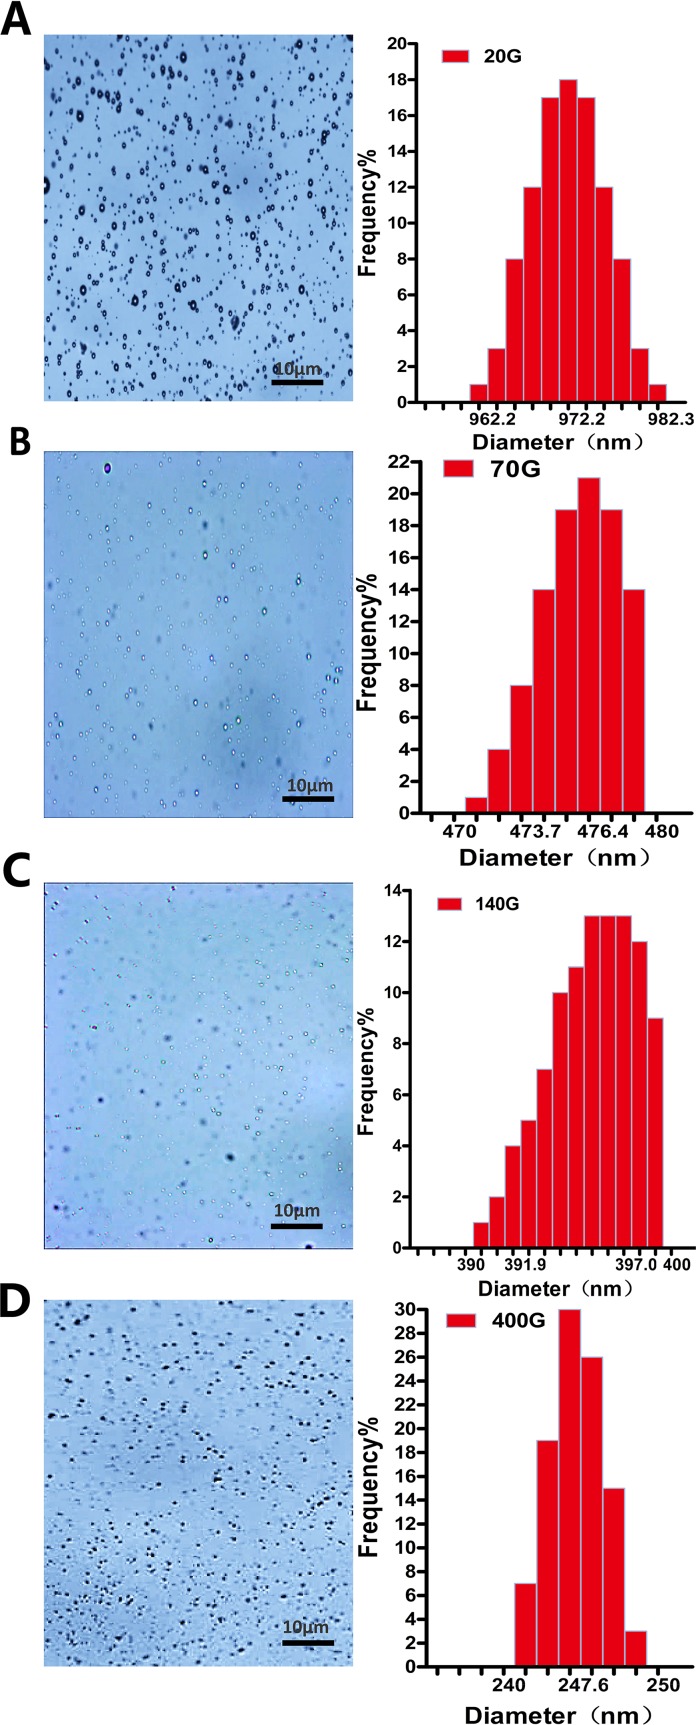
The morphology and particle size distribution of nanobubbles prepared by different centrifugations at 20 g (A), 70 g (B), 140 g (C), and 400 g (D).